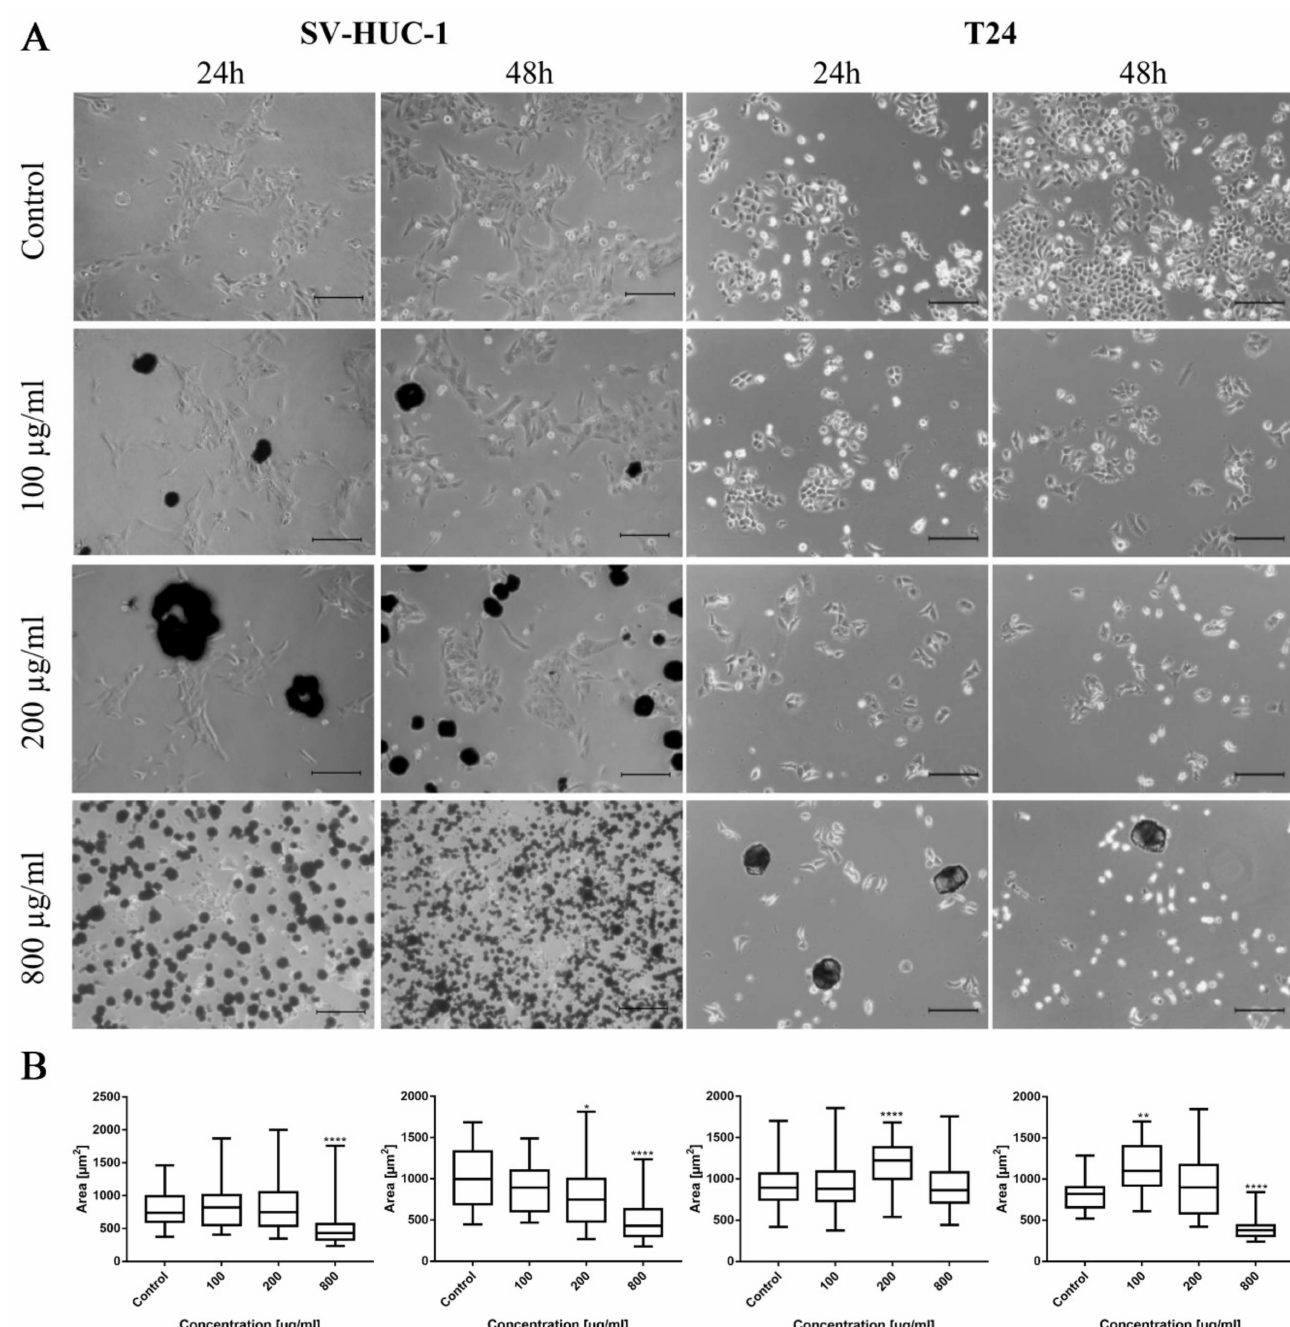
Figure 1. Bladder cell lines characteristic after ciprofloxacin treatment. ( A )—Morphology of bladder cell lines after ciprofloxacin treatment. Cell shrinkage, rounding, and detachment were visible after ciprofloxacin treatment, especially in higher concentrations. Ciprofloxacin crystal formation was visible in concentration 100 µ g/mL for SV-HUC-1 and 800 µ g/mL for T24, using an inverted light microscope (bar = 200 µ m). ( B )—Morphometric analysis of cells area. SV-HUC- 1—non-malignant human urothelium; T24—human bladder cancer; statistically significant results compared to control were presented: *— p ≤ 0.05; **— p ≤ 0.01; ****— p ≤